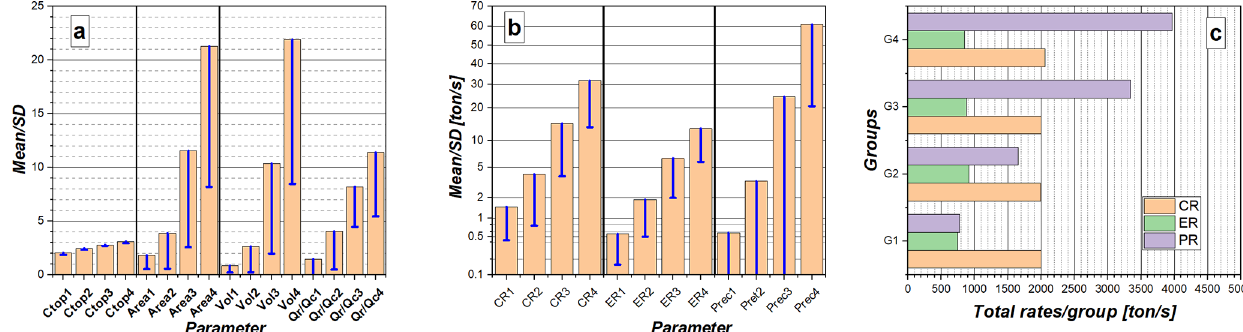
Figure 1. Mean and standard deviation of cloud physical parameters in each of the four groups. (a) cloud top, surface area, volume (Ctop, Area, Vol – in km, km 2 , km 3 , respectively), and rain to cloud water ratio (in percentages divided by a factor of 10); (b) per cloud conden- sation/evaporation and precipitation rate (PR – integrated over the cloud surface area) in t/s; (c) total CR/ER/PR integrated over the group